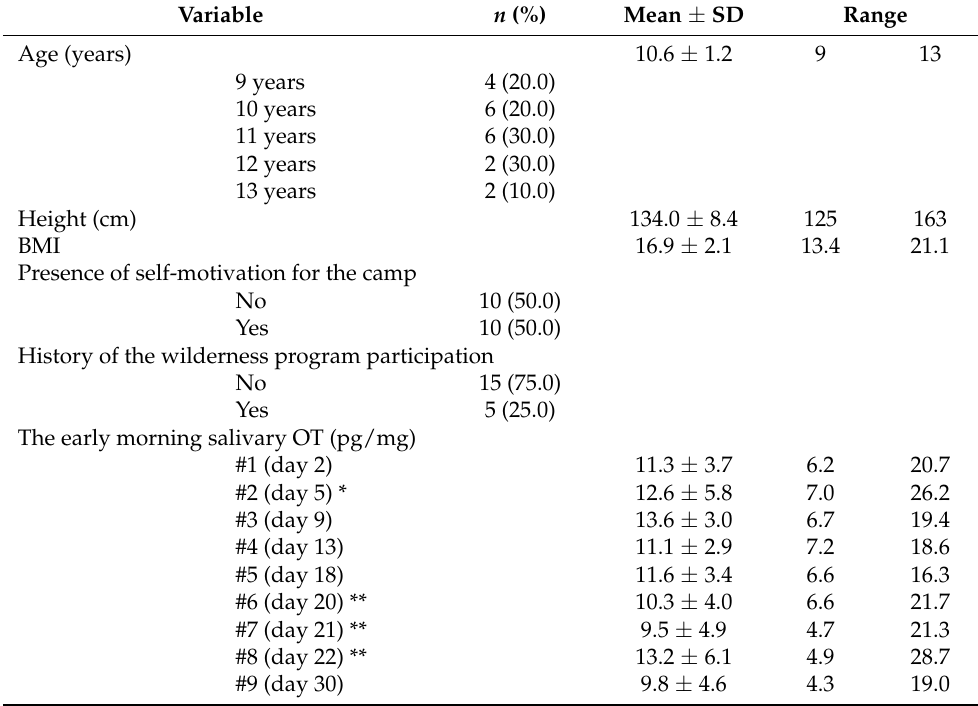
Table 2. Characteristics of the male participants ( n =